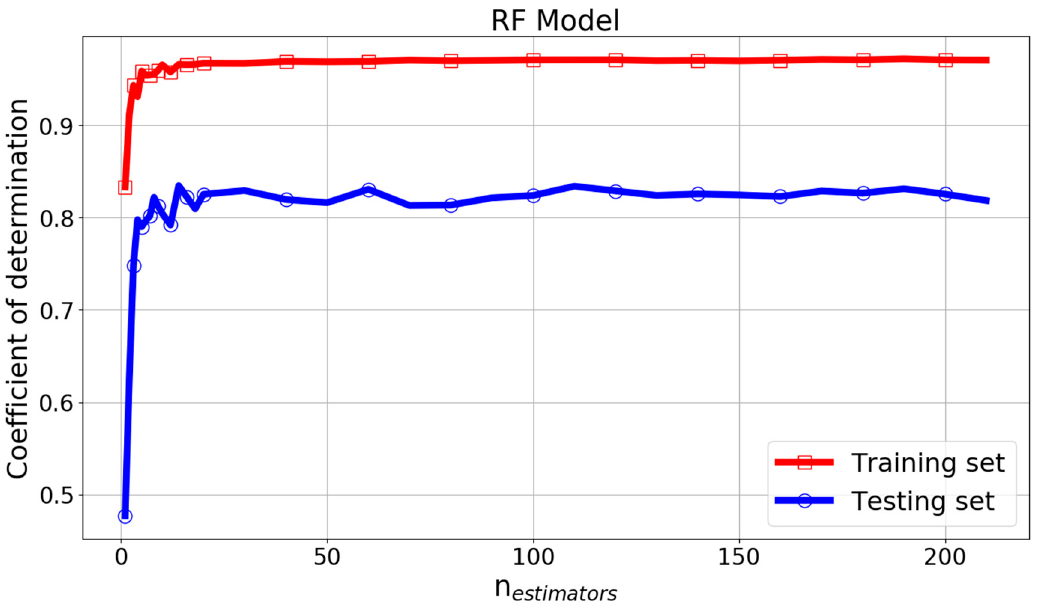
Figure 18. R 2 change curve of the RF model with parameter n estimators.